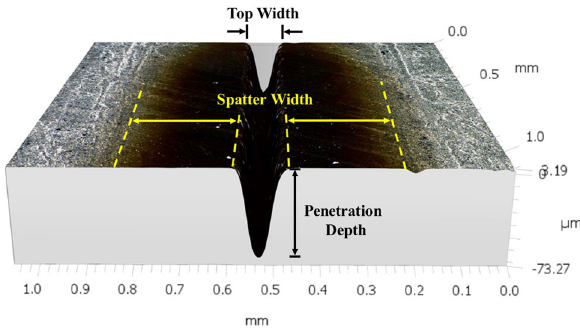
Figure 4. Illustrations of top width, penetration depth and spatter